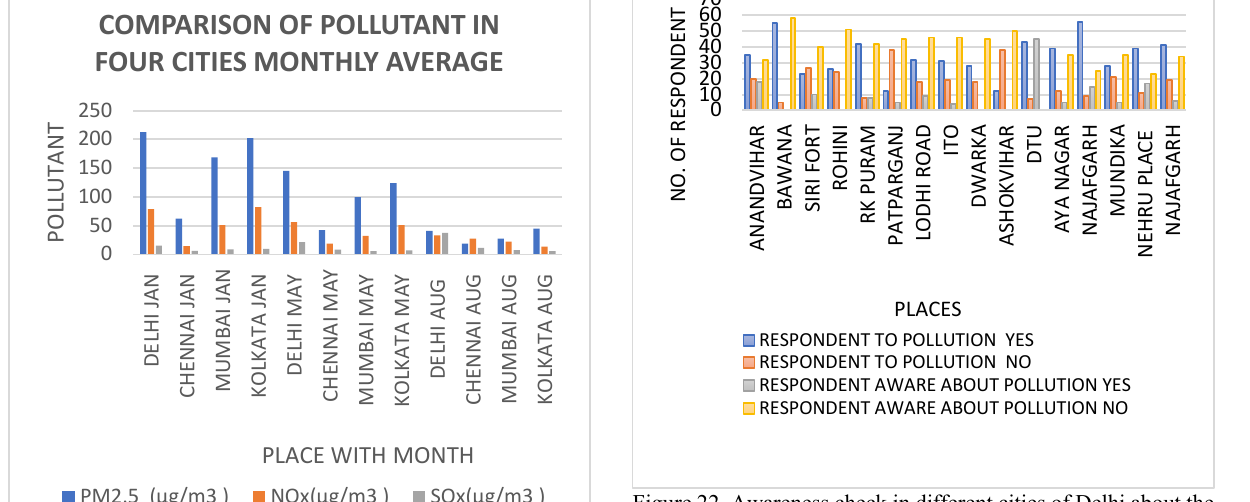
Figure 22. Awareness check in different cities of Delhi about the air pollution and its awareness in terms of